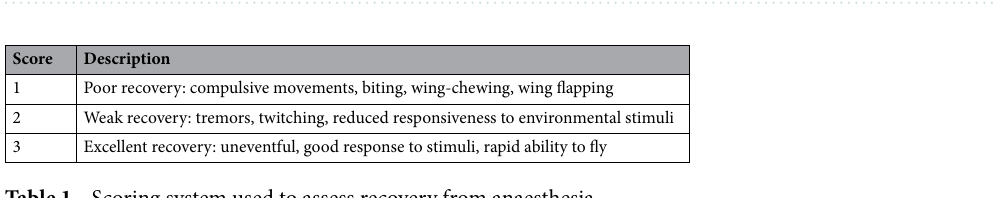
Table 1. Scoring system used to assess recovery from